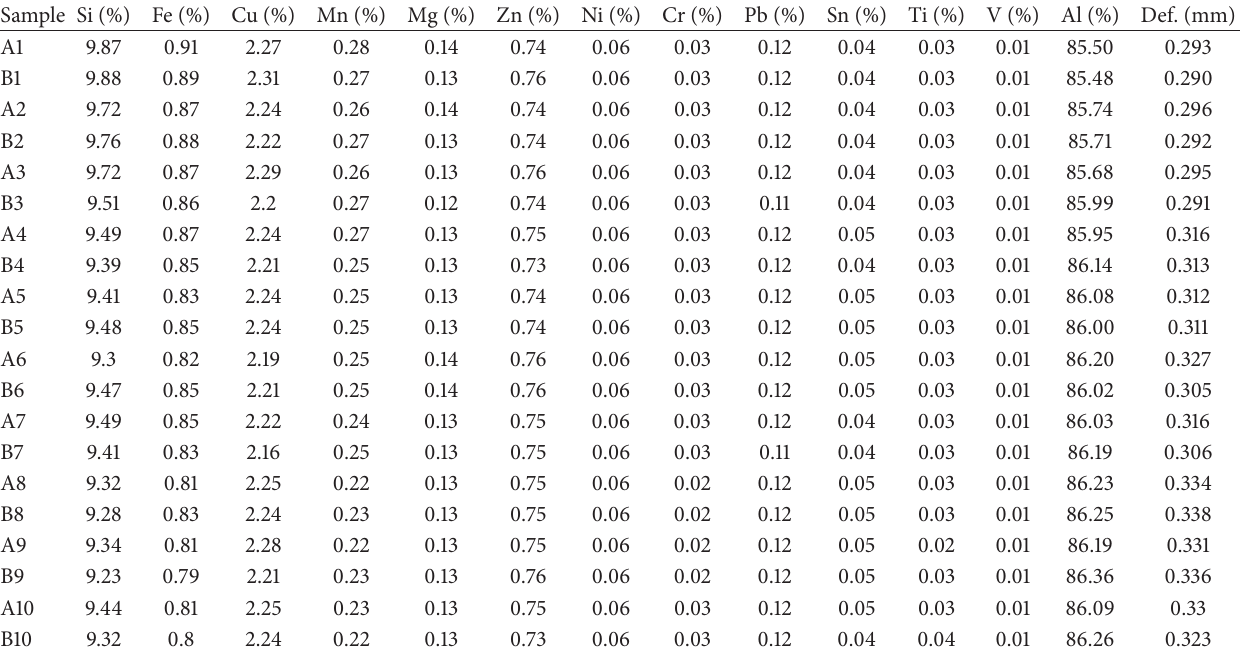
Table 4: Values of chemical compositions of particular cast samples and values of residual